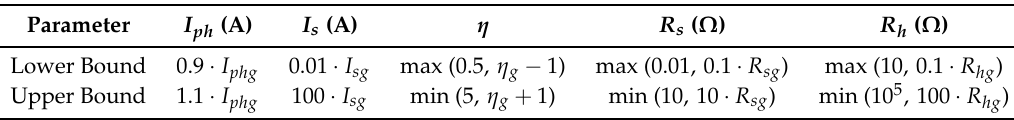
Table 2. SDM parameters’ real boundary